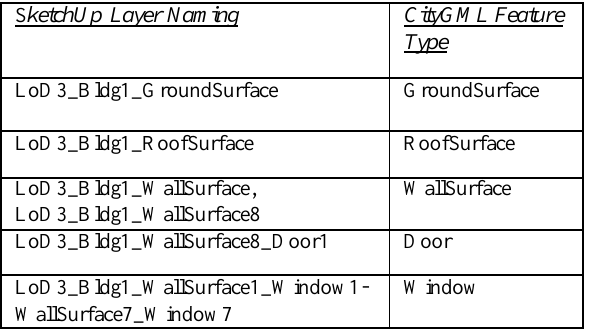
Table 1: Co-relation between layers and CityGML Features